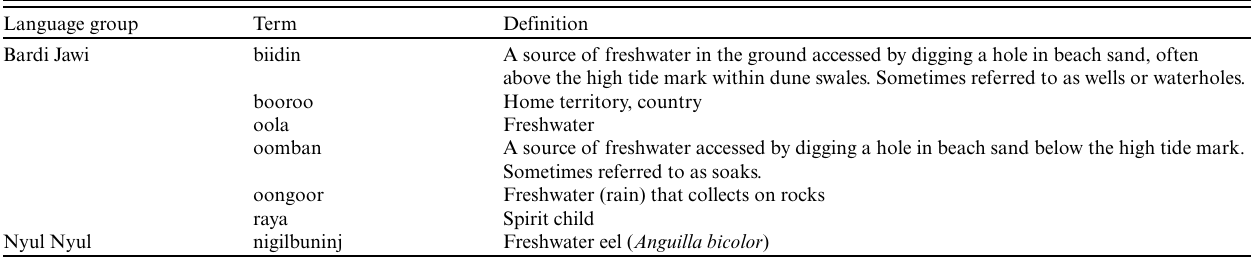
Table 1 . Some Bardi Jawi and Nyul Nyul terms for freshwater and terms used in this paper (for Bardi Jawi words see Aklif 1999). Language